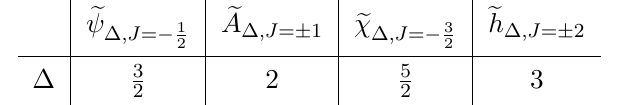
Table 5. Soft theorems without conformal shadow Goldstones for 1